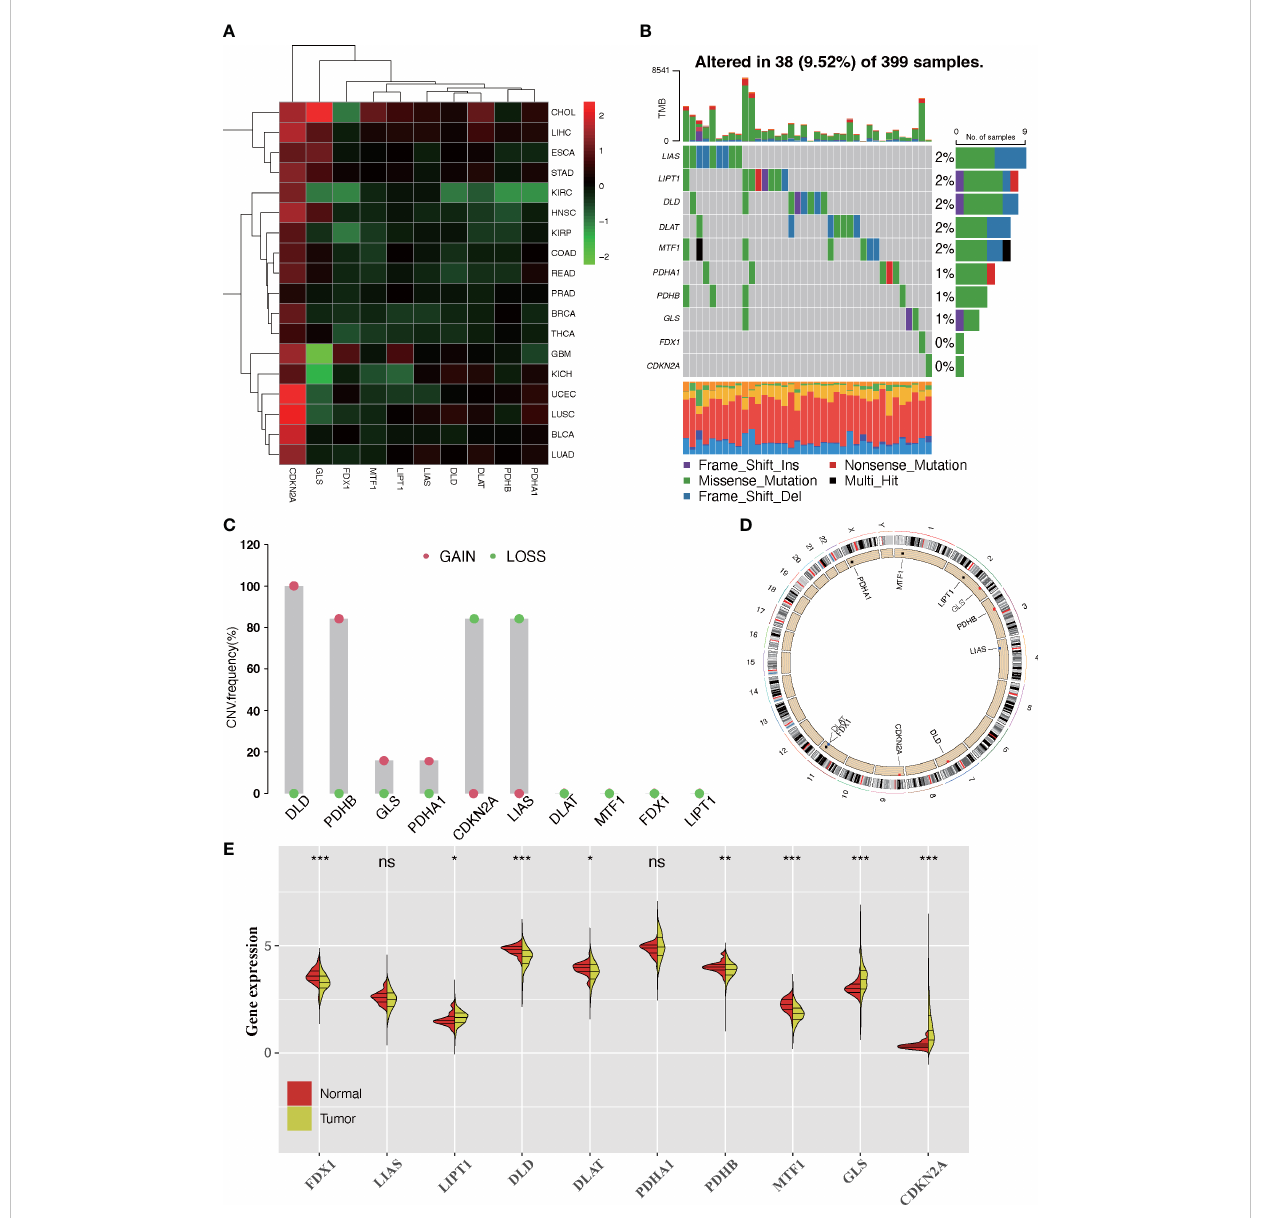
FIGURE 1 Landscape of expression and genetic alteration of cuprotosis-related genes (CRGs) in colorectal cancer. (A) The fold changes of the expression level alterations of CRGs in 18 cancer types, with red representing upregulated genes and green representing downregulated genes in the heatmap. (B) Thirty- eight of the 399 CRC patients developed genetic mutation of 10 CRGs. Each column represented an individual patient. The upper barplot showed the tumor mutational burden. The right barplot showed the frequency of each variant type. (C) The CNV frequency mutations of 10 CRGs. Alteration frequency was represented by the column height. Green dots represented the deletion frequency. Red dots represented the ampli fi cation frequency. (D) The location of CNV alteration of 10 CRGs on chromosomes. (E) The difference of mRNA expression level of 10 CRGs between normal and tumor CRC samples (TCGA-COAD and TCGA-READ). The asterisks represent the statistical p -value (ns: p > 0.05; * p < 0.05; ** p < 0.01; *** p <